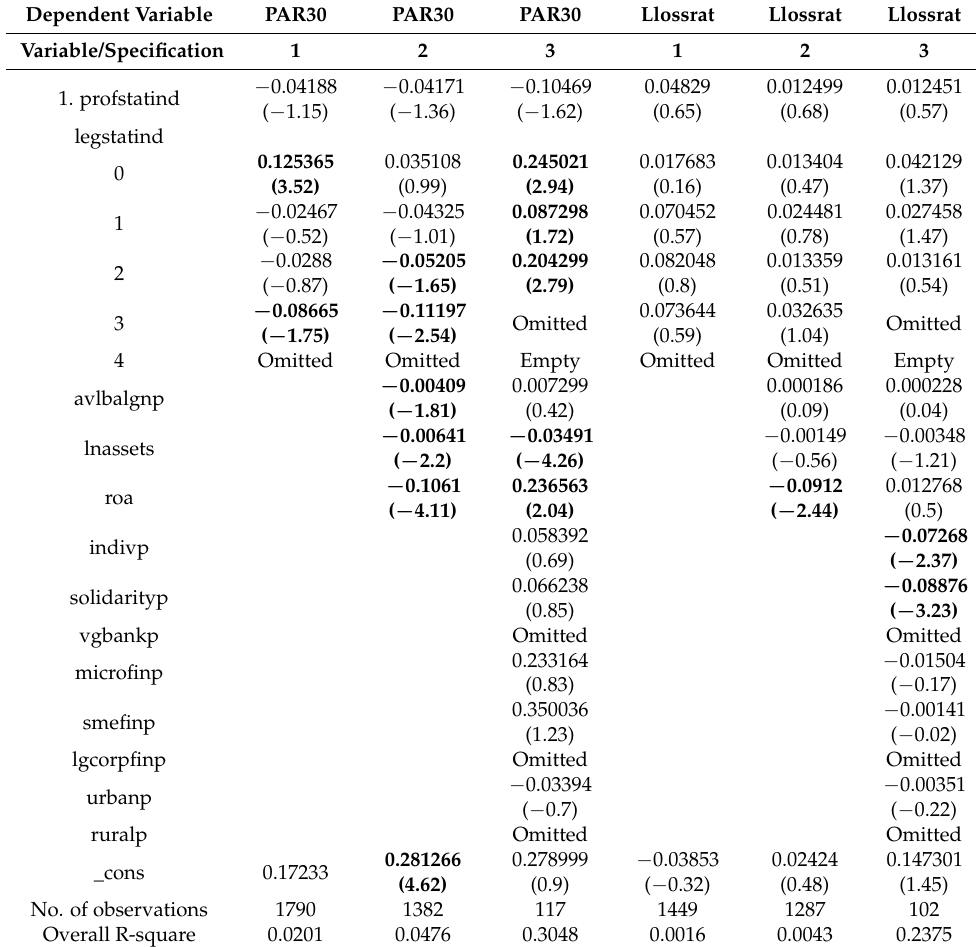
Table A3. PAR30 Panel regressions for Africa